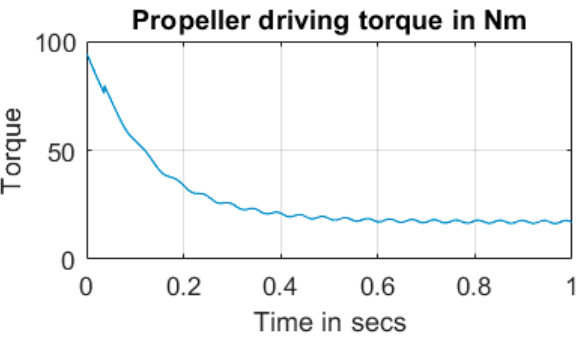
Figure 2. Variation of the PMSM load torque as a function of time over the timeframe of 1 s at normal room temperature.